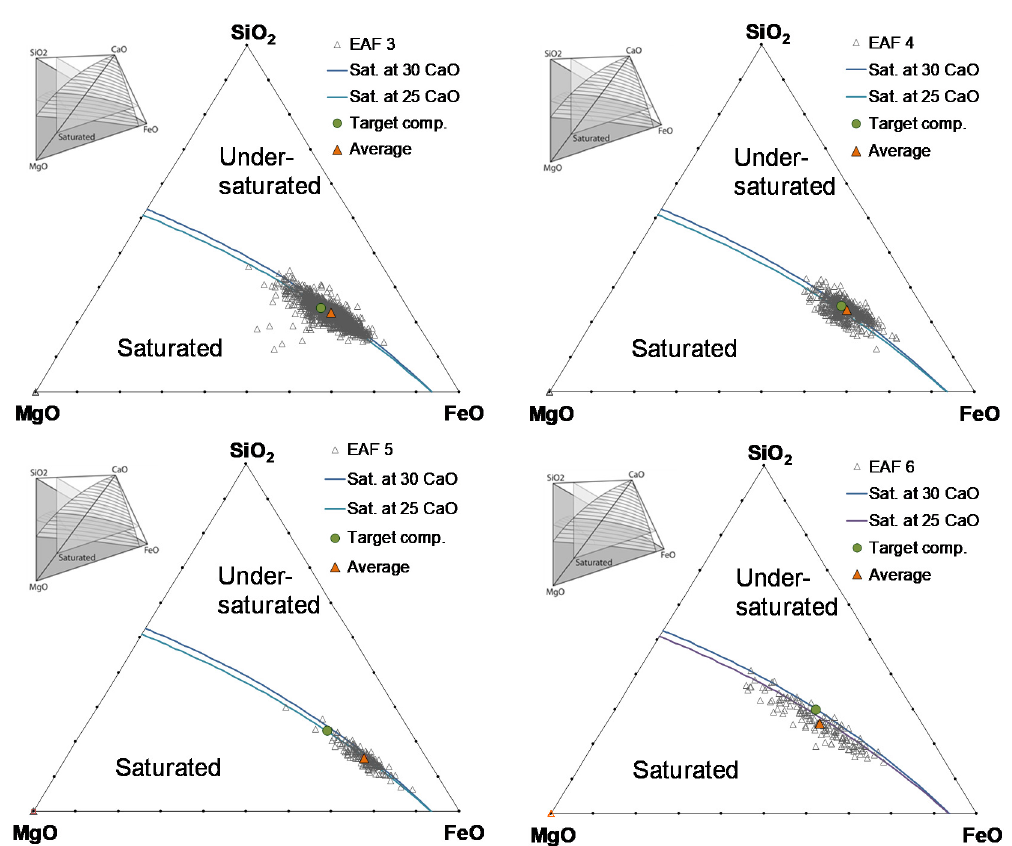
Figure 5. Distribution of slag analysis data from EAF heats for carbon steelmaking, in the system CaO–SiO 2 –FeO–MgO– 5%Al 2 O 3 ; lines indicate MgO saturation at 25% to 35% CaO and 1600 °C.